Question: How would you classify this visualization?
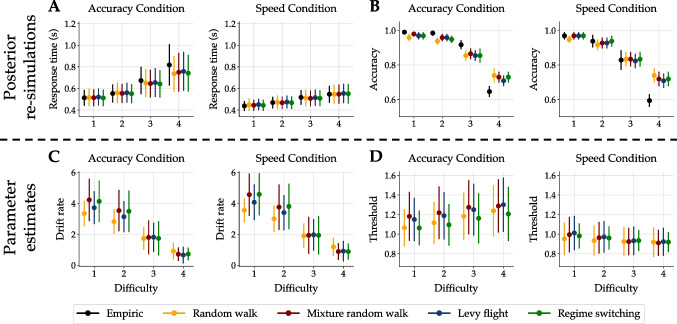
Answer: bar